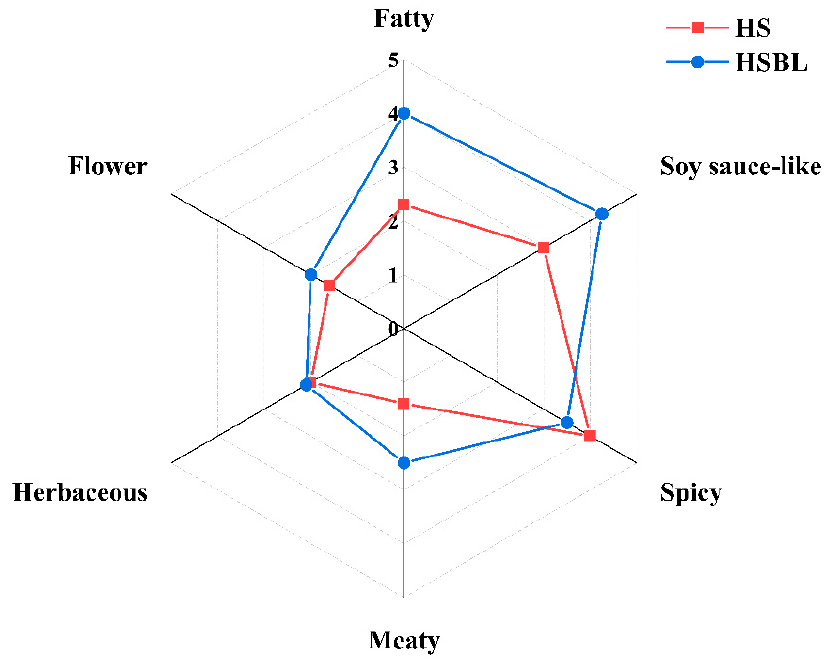
Figure 1. Sensory evaluation of Hotpot seasoning before and after boiling.